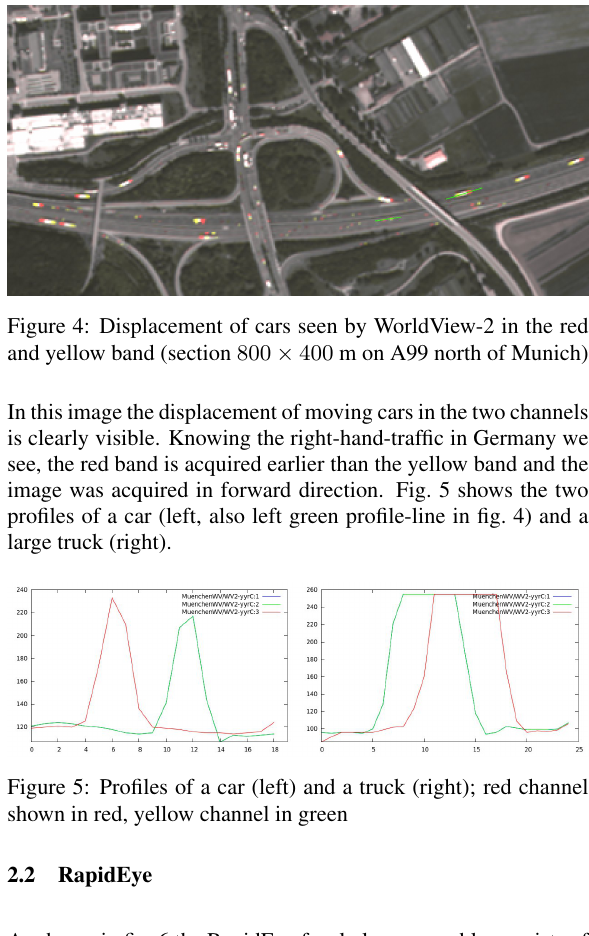
Figure 5: Profiles of a car (left) and a truck (right); red channel shown in red, yellow channel in